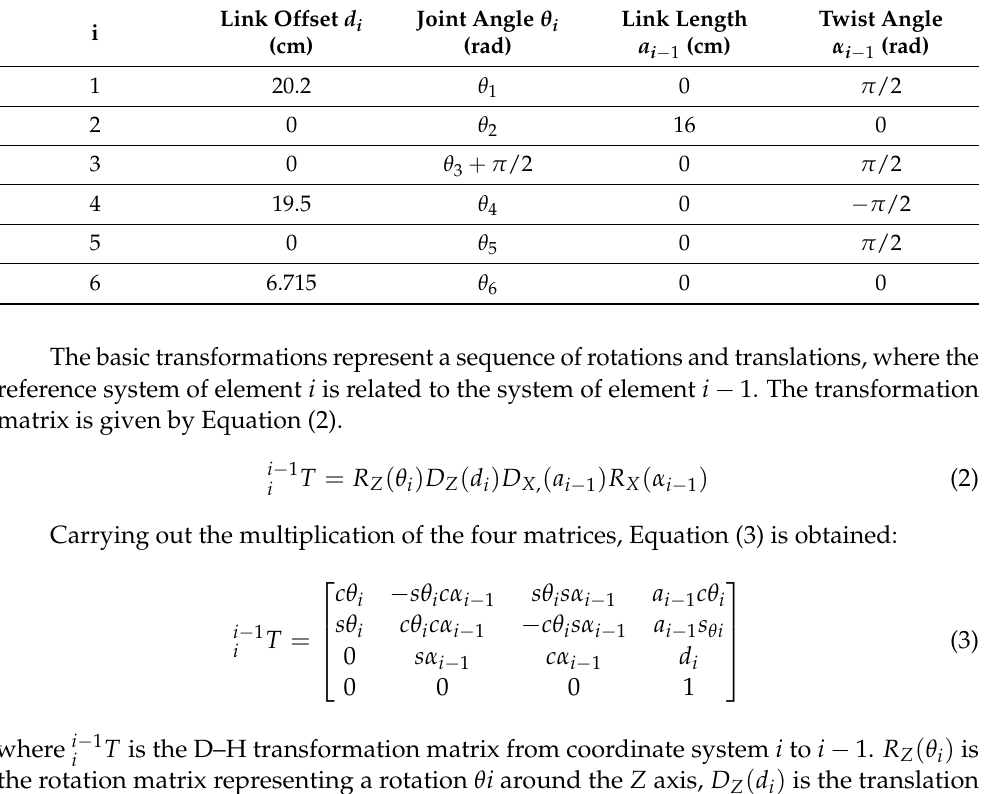
Table 1. D–H parameters of the Quetzal